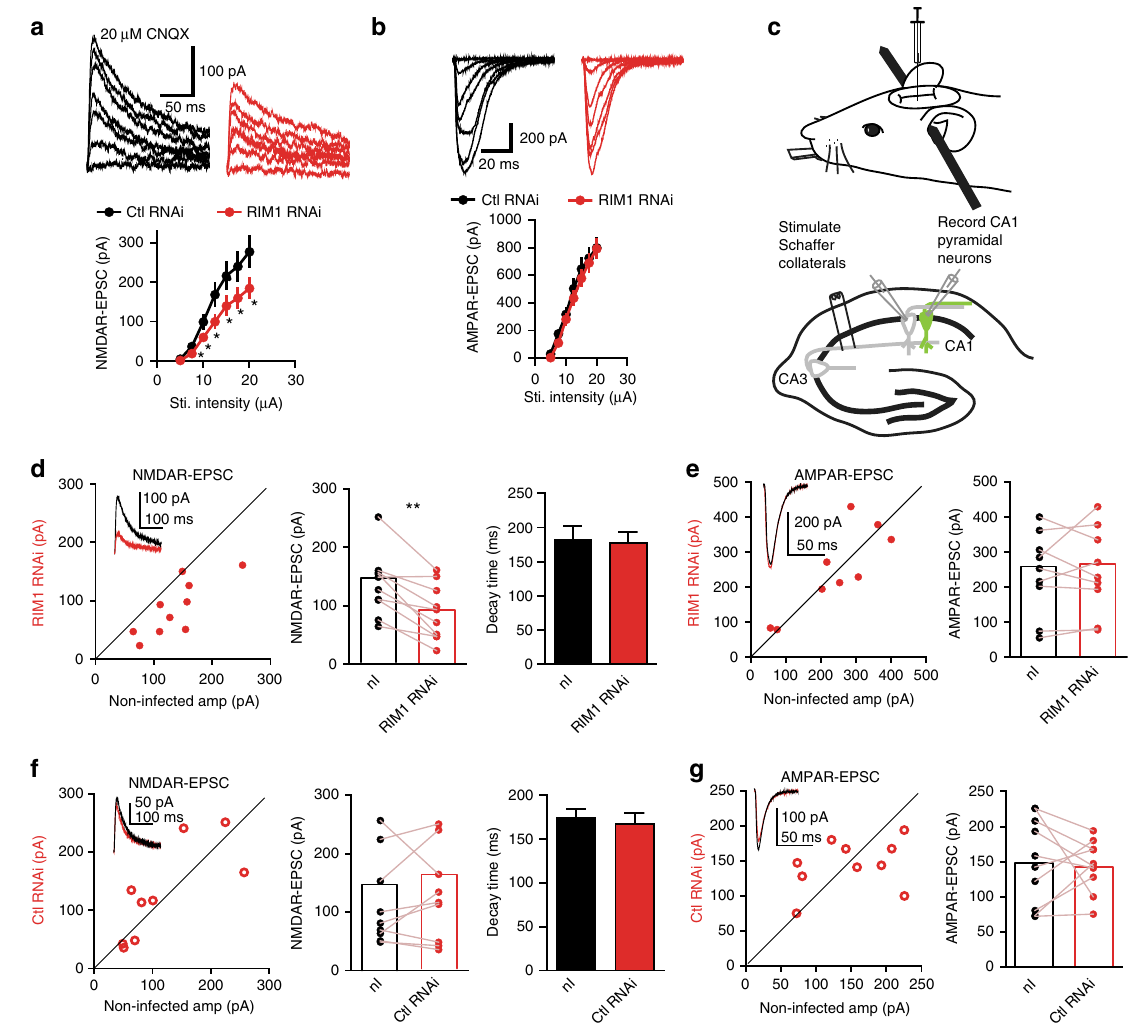
Fig. 3 Postsynaptic RIM1 KD impairs NMDAR-mediated transmission. a NMDAR input/output curve in CA1 pyramidal neurons reveals a signi fi cant effect of RIM1 RNAi on the amplitude of NMDAR current across stimulation intensities. EPSCs from two representative cells are shown above the graph; n = 9 cells from 4 mice for RIM1 RNAi group and 8 cells from 4 mice for control RNAi group. The data were analyzed in separate t -tests at each stimulus intensity; * p < 0.05. b Measurement of AMPAR-EPSCs elicited by isolated stimuli applied with increasing strength to obtain input/output relationships in neurons with control RNAi or RIM1 RNAi. n = 10 cells from 5 mice for each group. The data were analyzed in separate t -tests at each stimulus intensity; p > 0.05. c Diagram (upper) showing mouse on stereotaxic apparatus for injection of lentivirus. Schematic (lower) illustrating paired recordings from infected and neighboring uninfected (control) neurons in the pyramidal layer of CA1. d Postsynaptic RIM1 KD reduces the amplitude of NMDAR-mediated EPSCs at SC-CA1 synapses ( n = 10 pairs of neurons from 5 mice. Paired t -test; ** p < 0.01) but does not modify their decay time compared to neighboring uninfected neurons ( t -test, p > 0.05). Sample traces are shown in the inset (red lines, infected neurons; black lines, neighboring non-infected neurons); nI non- infected. e Postsynaptic RIM1 KD does not change the amplitude of AMPAR-mediated EPSCs at SC-CA1 synapses compared to neighboring uninfected neurons; n = 9 pairs of neurons from 5 mice. Paired t -test, p > 0.05. f Control RNAi does not affect NMDAR-mediated EPSCs at SC-CA1 synapses (amplitude and decay time), as compared to neighboring uninfected neurons. Sample traces are shown in the inset; n = 9 pairs of neurons from 4 mice. Paired t -test, p > 0.05. g Control RNAi does not modify the amplitude of AMPAR-mediated EPSCs at SC-CA1 synapses; n = 10 pairs of neurons from 6 mice, p > 0.05, paired t -test. In all panels, bar graphs and individual points represent the mean ± s.e.m.; * p < 0.05, ** p < 0.01, *** p <